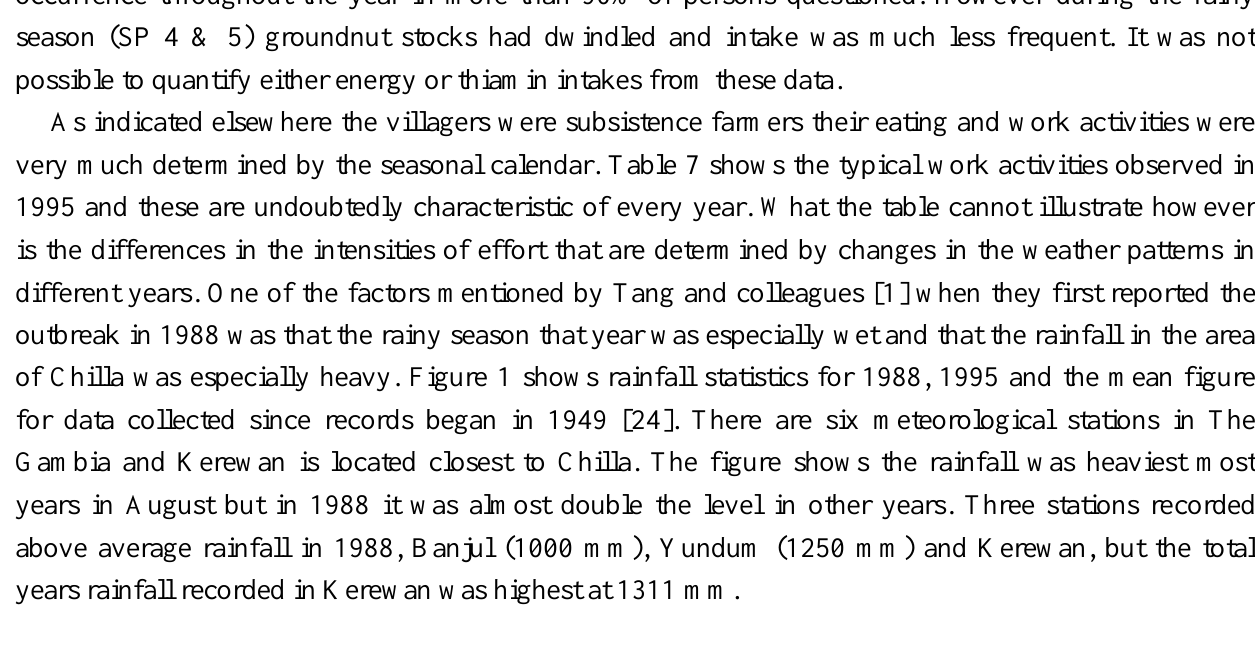
Table 6. Seasons of most frequent consumption of snack foods and individual fruits, vegetables and bush foods eaten in Chilla 1,2,3